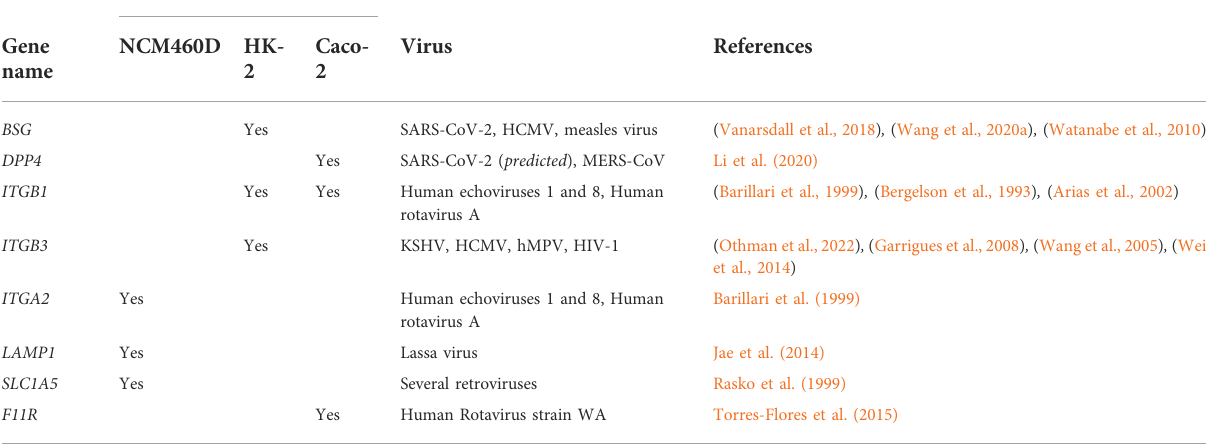
TABLE 1 List of receptors clustered in the “ viral entry into the host cell ” term. For each protein the gene name, the membership dataset, the viruses, and the literature references in which the protein has been demonstrated to be a receptor.